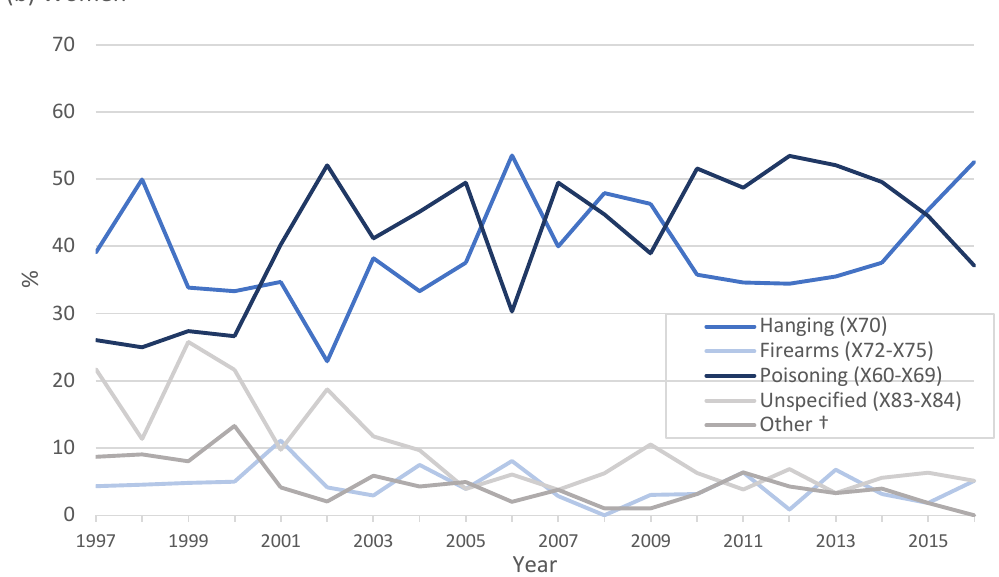
Figure 5. Proportion of suicide by method in (a) men and (b) women in South Africa, 1997 to 2016; † other includes intentional self-harm by drowning (X71), fire, heat and hot substances (X76–X77), blunt or sharp object (X78–X79), jumping from a high place or moving object (X81) and crashing of motor vehicle (X82). ( a ) Men; ( b ) Women.